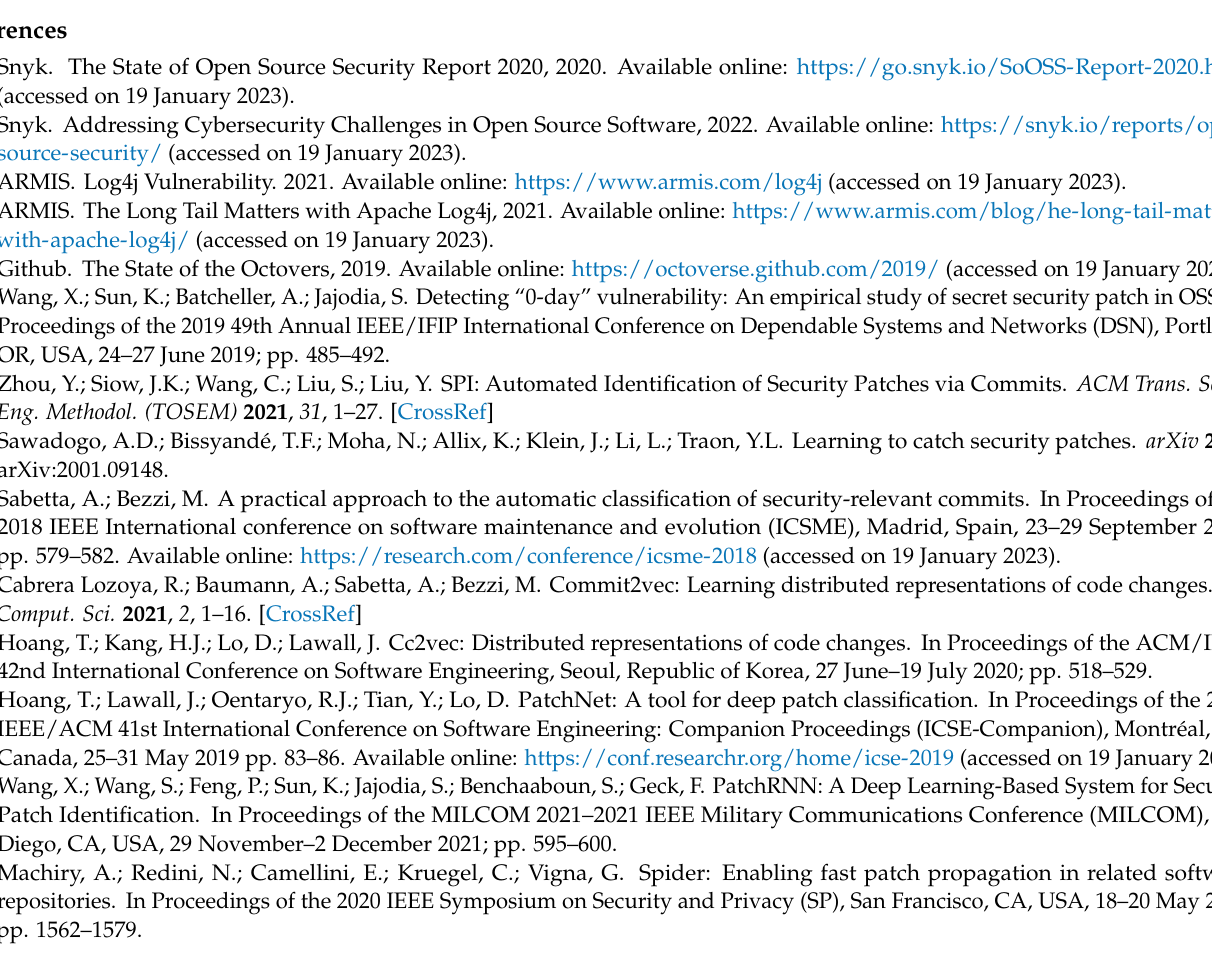
Figure A2. The processed control dependency graph of quick